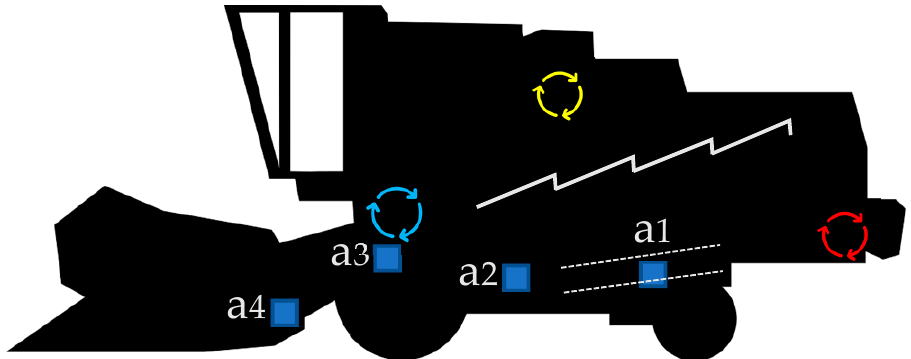
Figure 1. Diagram of a combine harvester. The blue arrows represent the location of the thresher, the yellow ones the location of the engine, and the red ones the location of the chopper. The jagged line represents the straw walkers and the dotted lines, the sieve box. The blue square symbols show the location of the accelerometers, labeled a1–4.